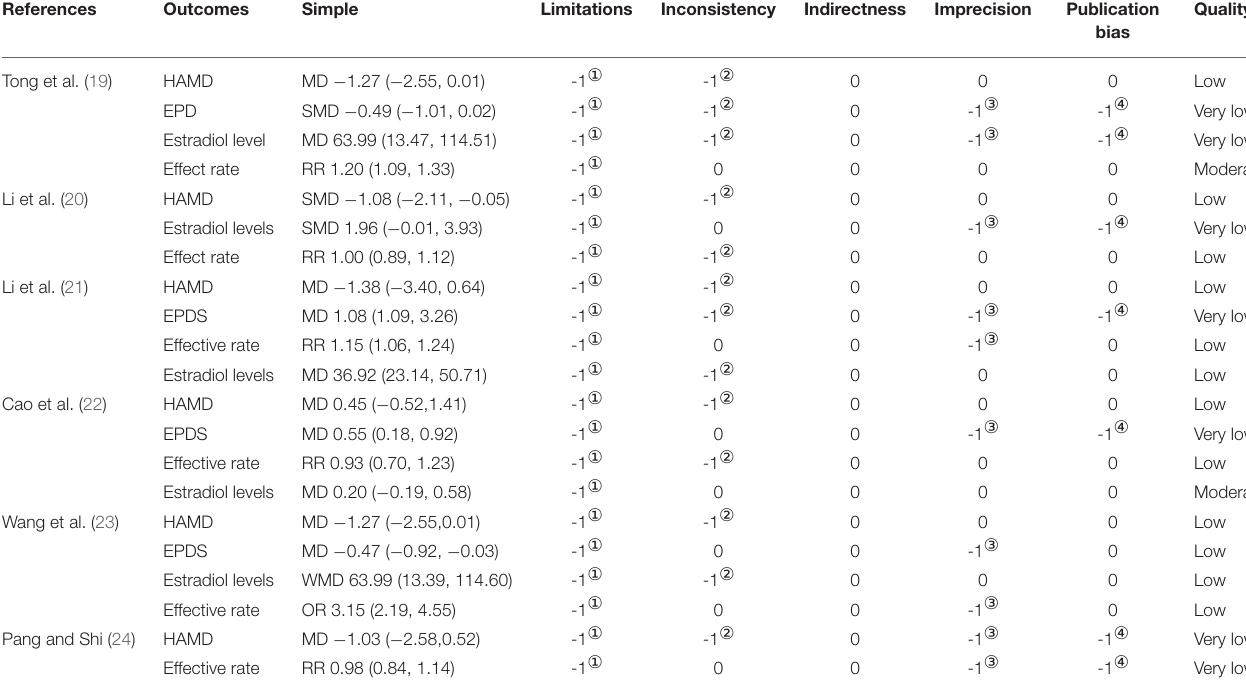
TABLE 4 | Certainty of evidences